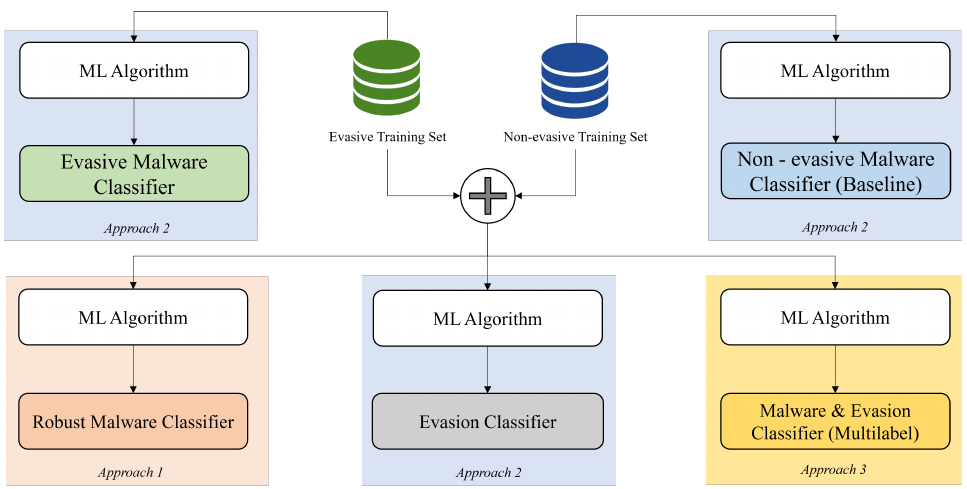
Figure 3. Training in the three